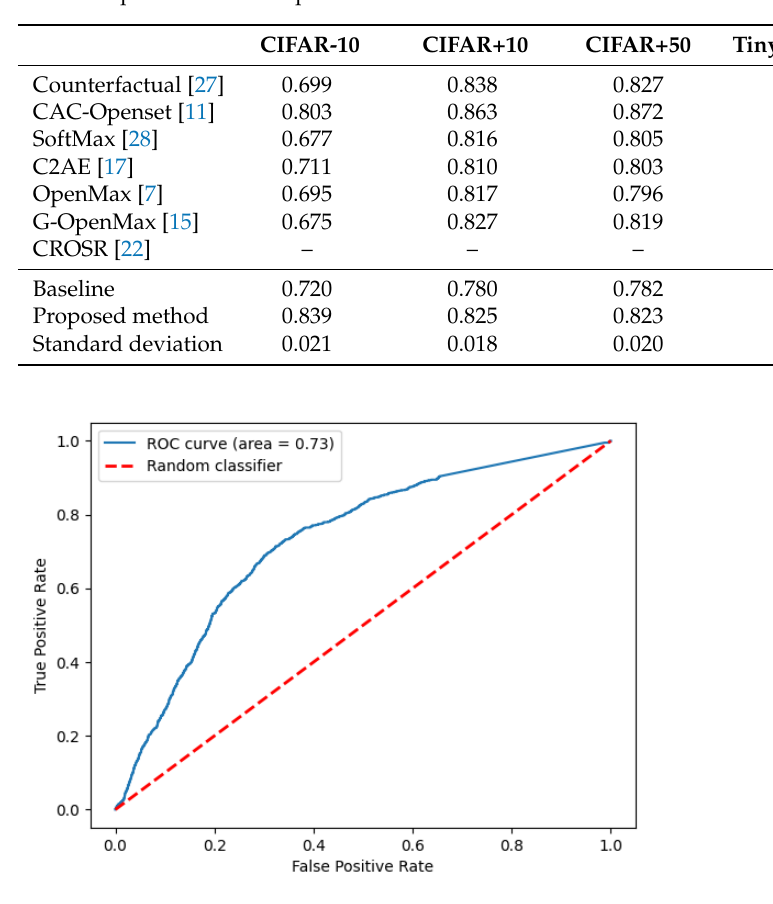
Figure 3. The receiver operating characteristic curve of the model on TinyImageNet in one of the 10